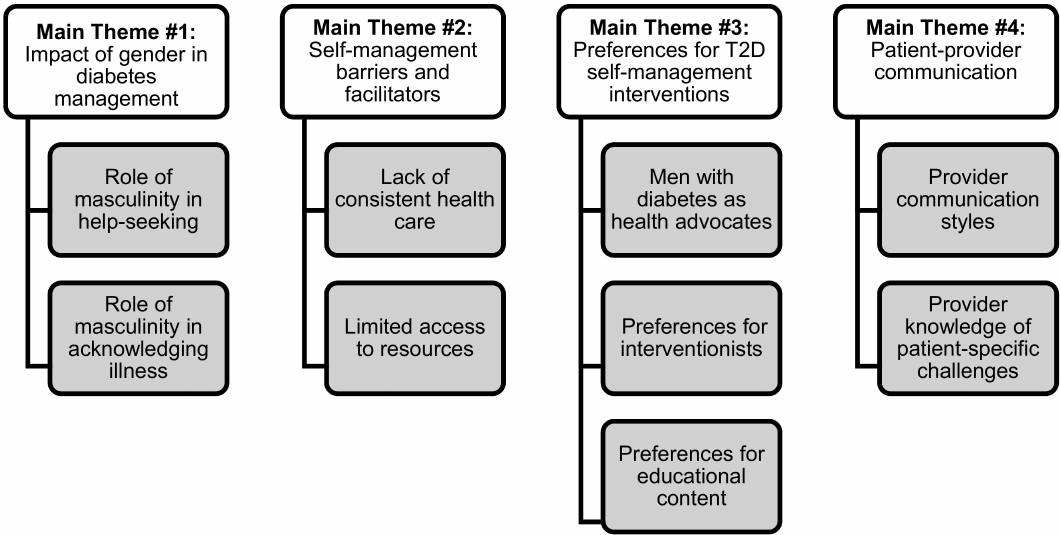
Figure 1. Main Theme and Sub-Theme